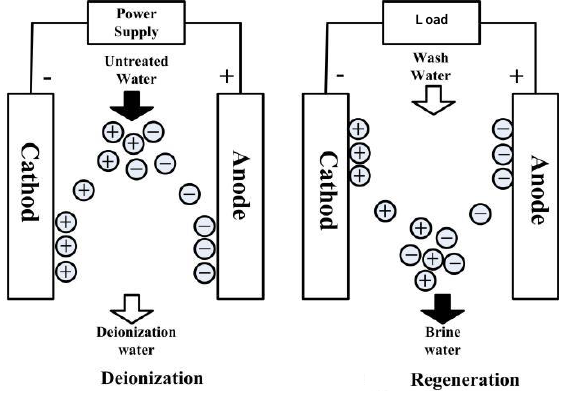
Figure 1. Principle of the capacitive deionization process.